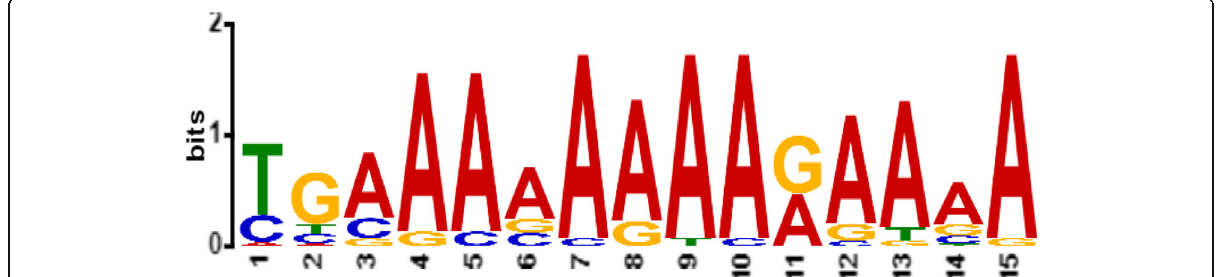
Fig. 1 Sequence logo for the identified common promoter motif M Sc 1 gene for gene encoding alcohol production gene in S. cerevisiaea